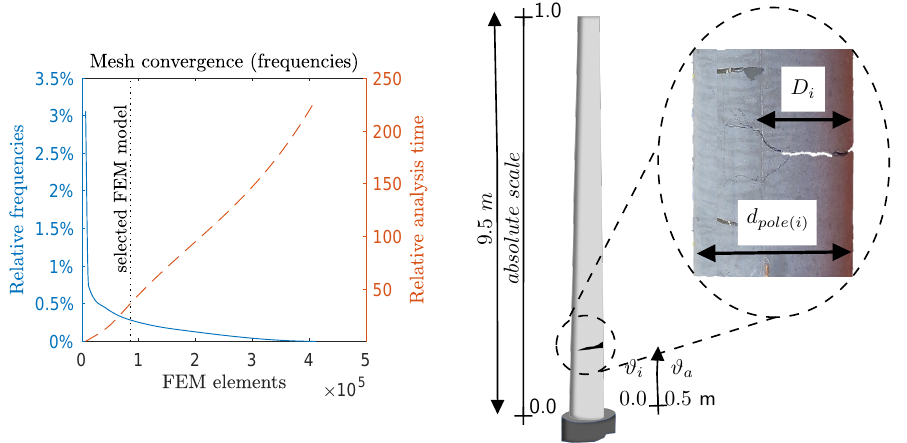
Figure 2. FEM mesh convergence analysis ( left ), and a description of the local damage ( right